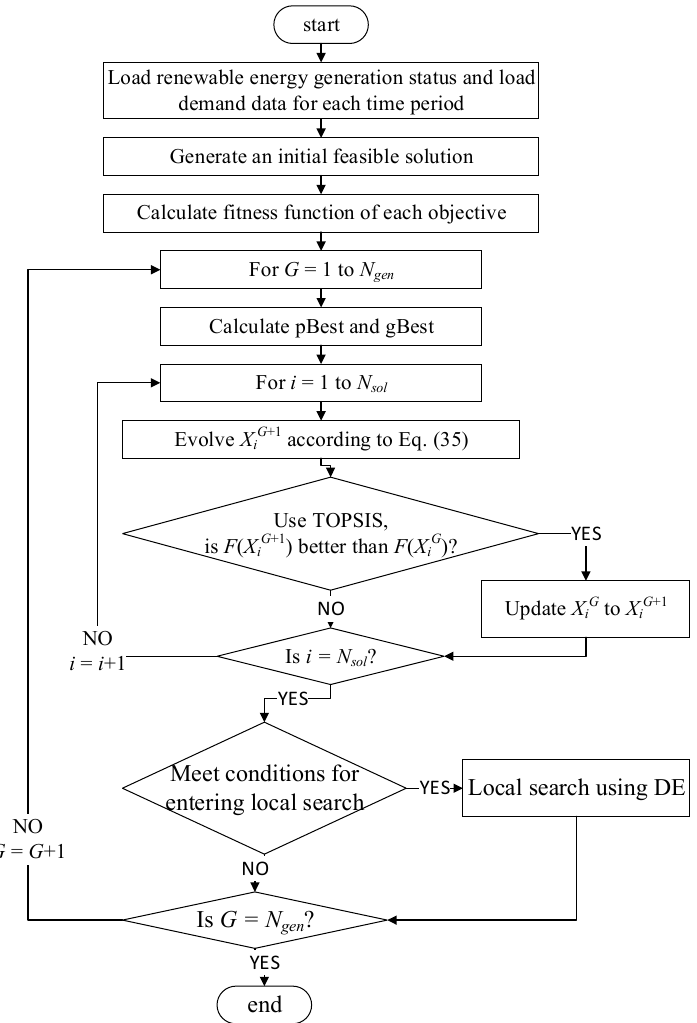
Figure 1. Proposed method flowchart.